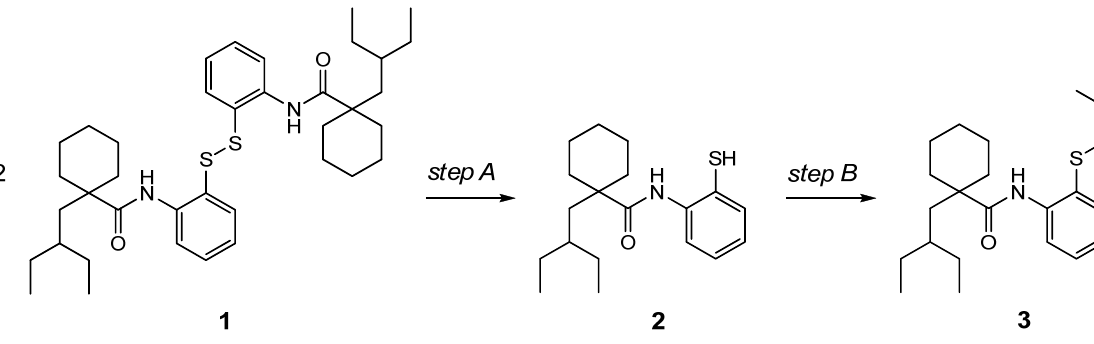
Figure 1. Synthesis of dalcetrapib ( 3 ). Step A: reduction; Step B: acylation (see